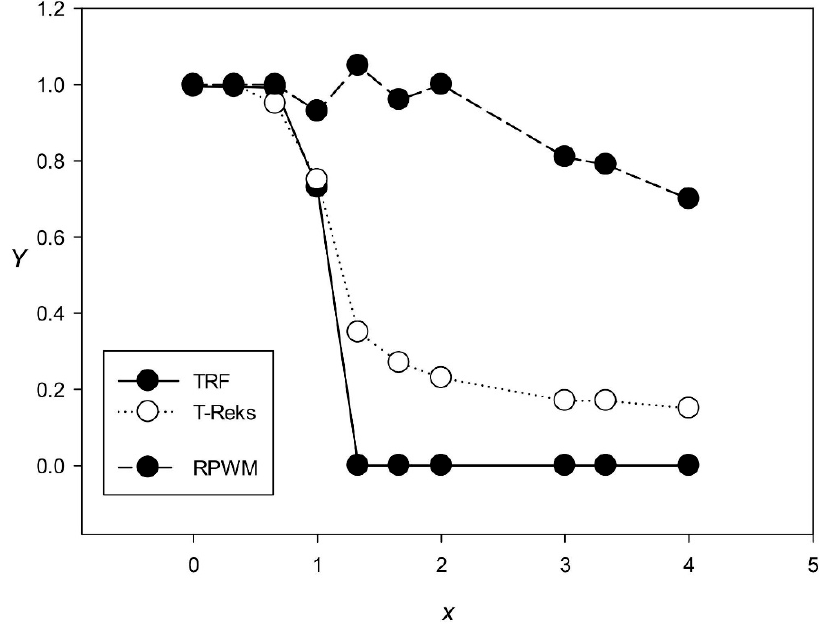
Figure 2. Dependence of the proportion of identified tandem repeats ( Y ) on the number of introduced base substitutions ( x ) for the Tandem Repeat Finder (TRF), T-Reks, and random position weight matrices (RPWMs) programs. The analyzed sequences contained 100 repeats 6 nt long; each sequence had a different number of base substitutions along with 5 insertions and 5 deletions at random positions.